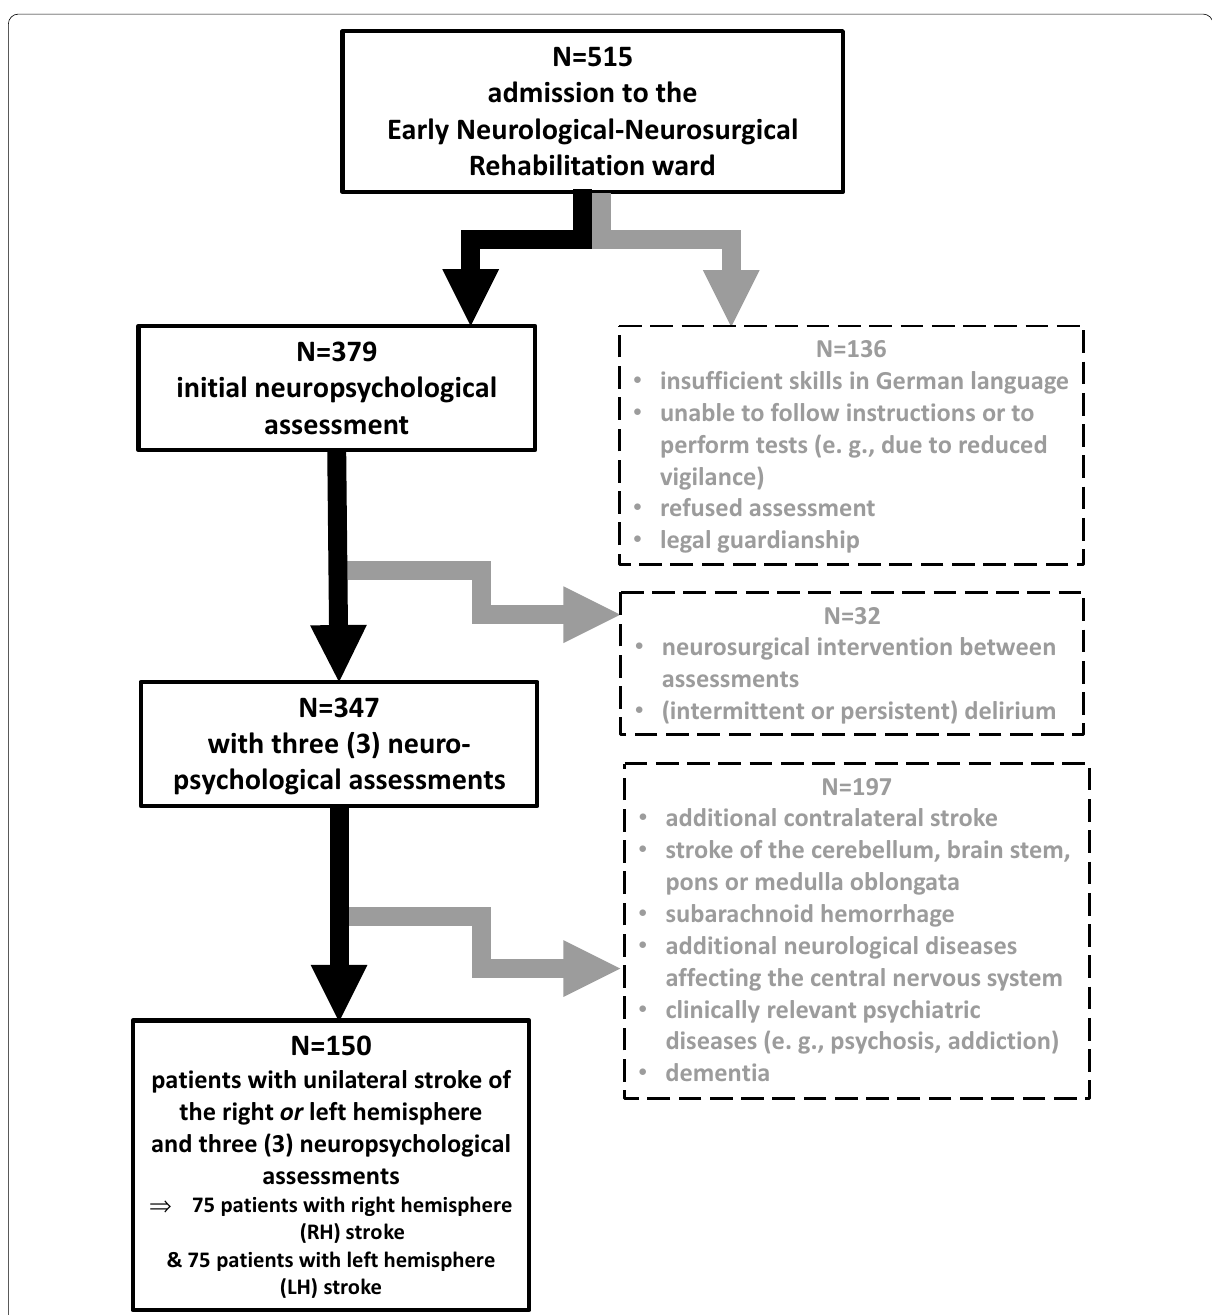
Fig. 1 Composition process of the sample. Starting from 515 data sets, 150 remained in the final sample for evaluation (75 patients with left hemisphere (LH) stroke and 75 patients with right hemisphere (RH) stroke). Exclusion criteria are described on the right side in the dashed